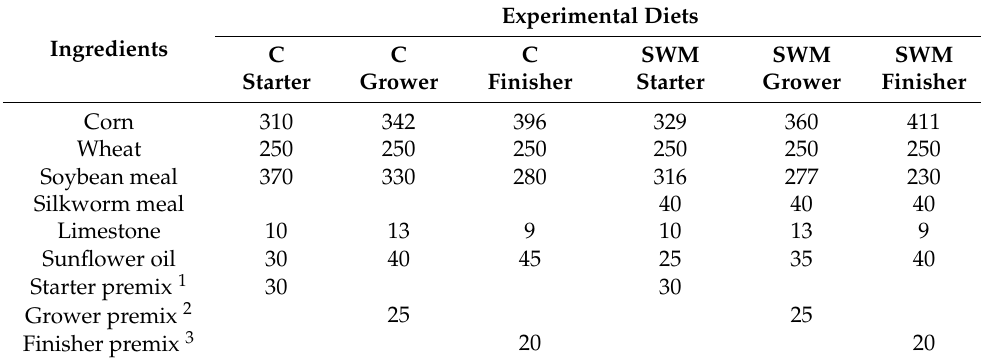
Table 1. Ingredients of the experimental diets (g/kg